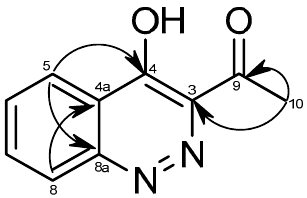
Figure 3. Selected key correlations in the HMBC spectrum ( ) of 7.